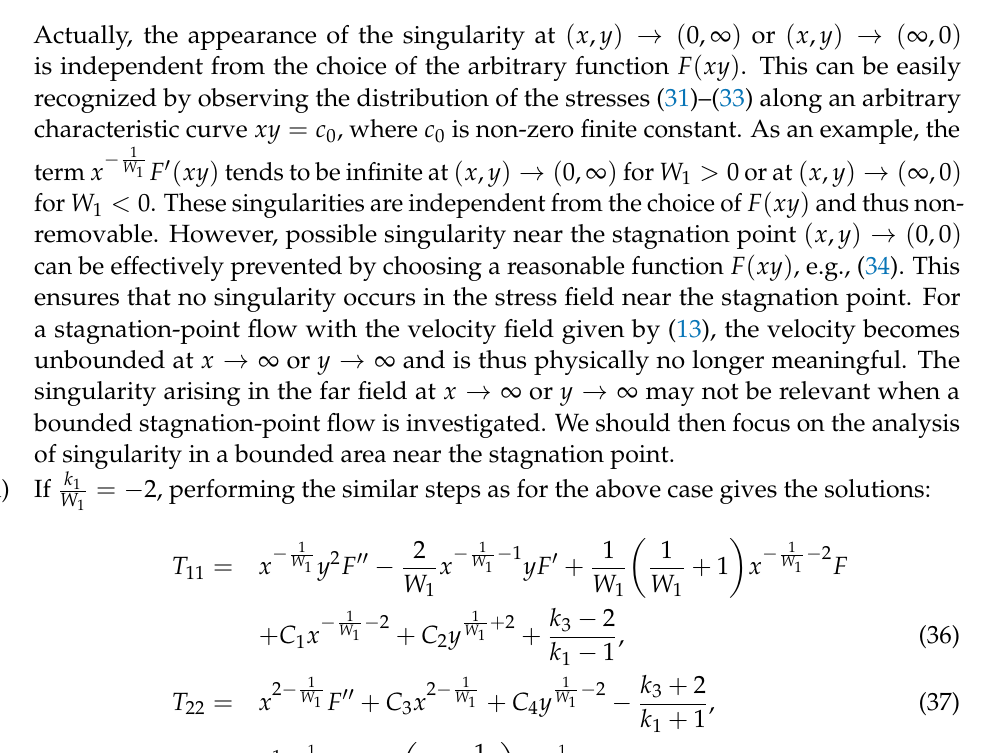
Figure 3. Stress component T 12 with a spatial resolution of x ∈ [ 0 : 0.001 : 0.2 ] , y ∈ [ 0 : 0.001 : 10 ]